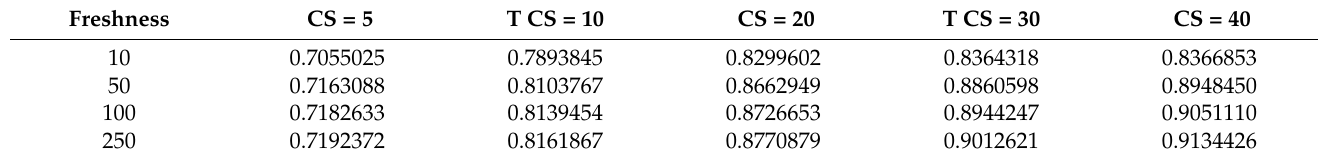
Table 2. Server hit reduction for different freshness values and CS sizes.